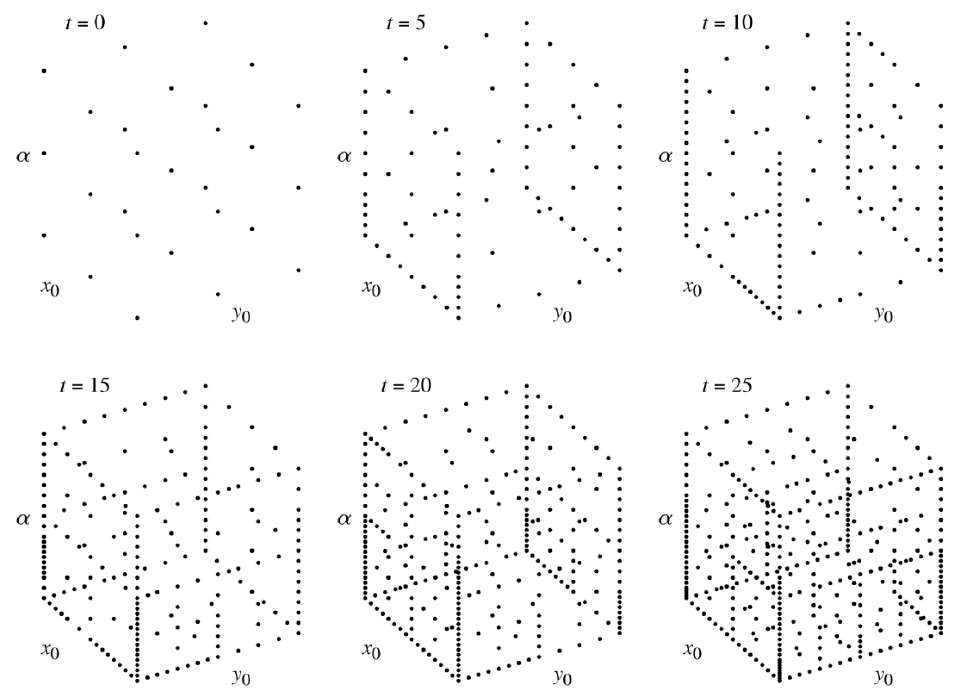
Figure 11. The grid obtained in the process of solving the system given by Equation (10).